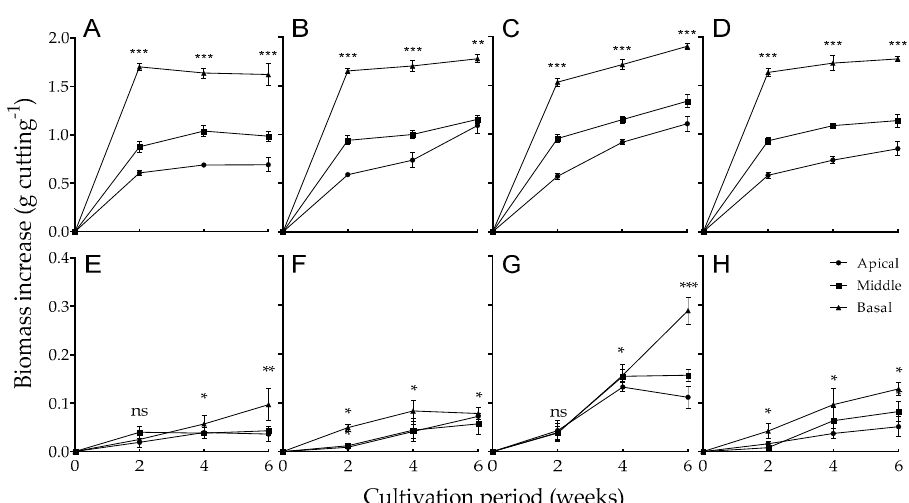
Figure 2. Biomass increase of ( A – D ) shoots and ( E – H ) roots among apical, middle, and basal rosemary cuttings irradiated with ( A , E ) natural sunlight, ( B , F ) fluorescent lamp light, ( C , G ) blue light, and ( D , H ) red light for six weeks. Error bars indicate the mean ± SE from three replicates (n = 8). Asterisks over data points indicate significant differences at p < 0.05 (*), <0.01 (**), and <0.001 (***); not significant; ns. There were statistical differences in the increase of shoot fresh weight among cutting positions ( p < 0.001), and in the increase of root fresh weight among light conditions ( p < 0.01) and culture period ( p < 0.01).